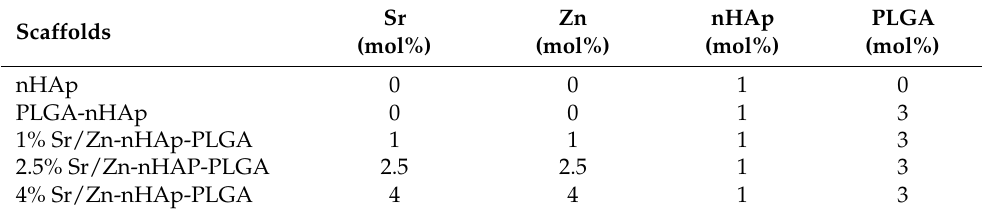
Table 1. Composition of different Sr/Zn-nHAp-PLGA scaffolds.